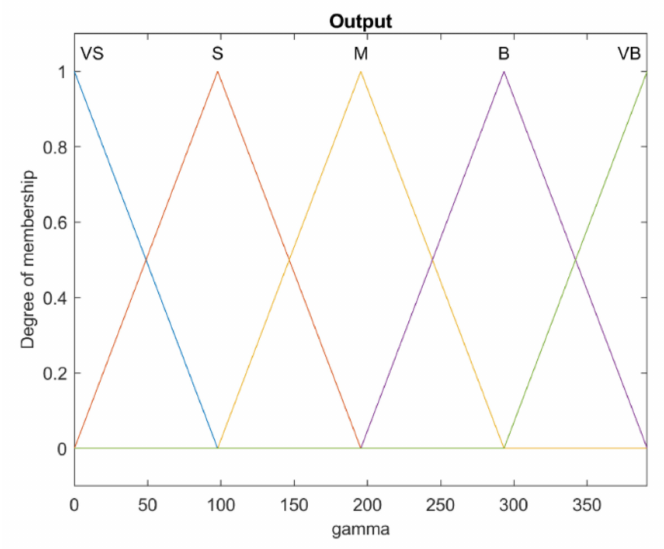
Figure 5. Output membership functions of the controller gains of Γ